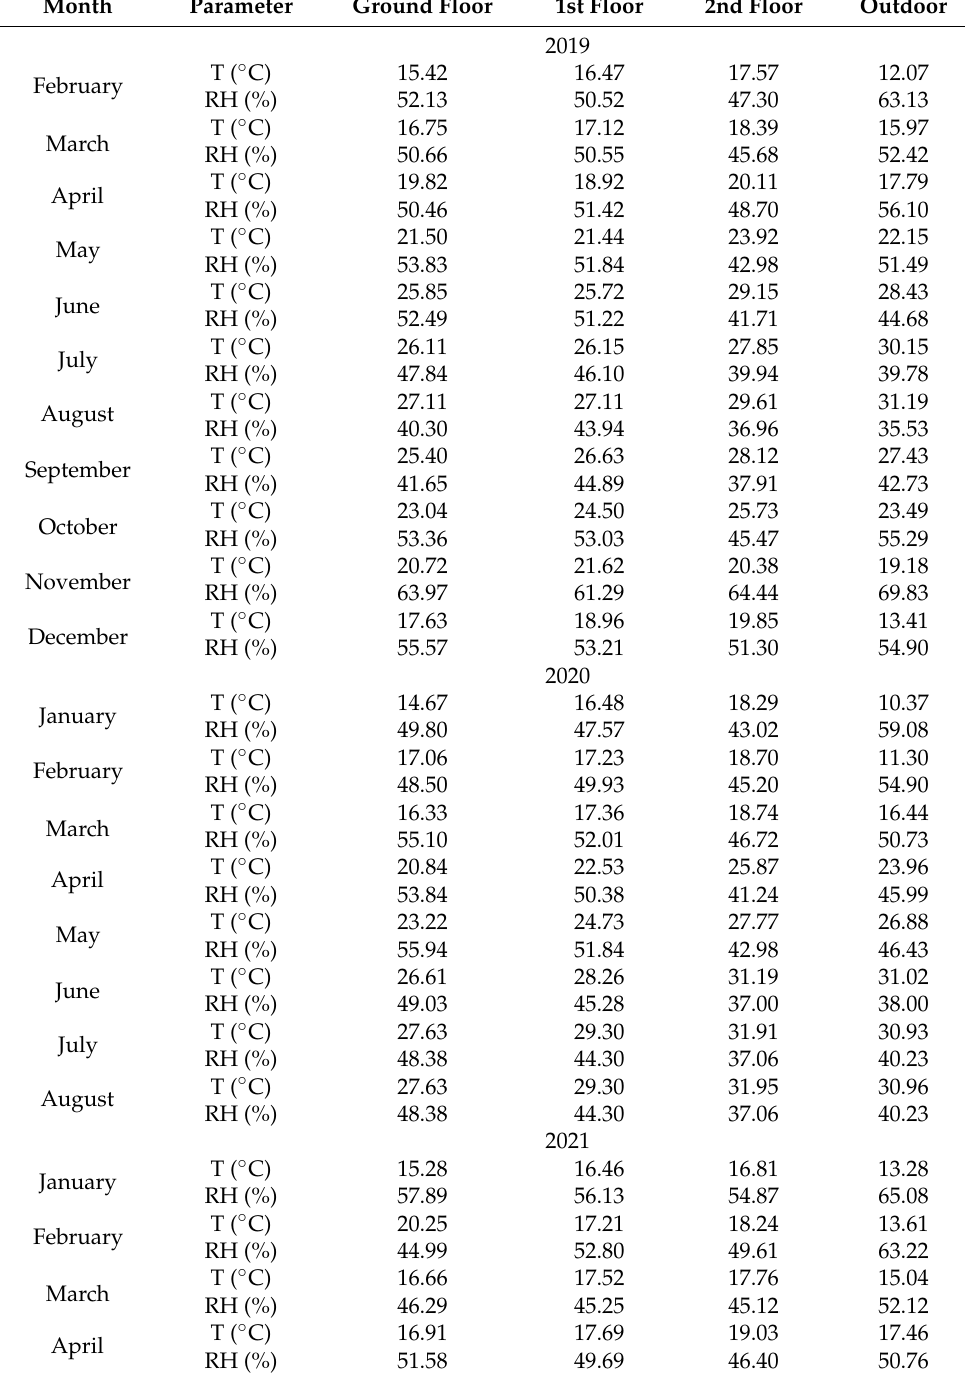
Table 1. Average monthly values of temperature ( ◦ C) and relative humidity (%) in and out of the building during the entire experimental